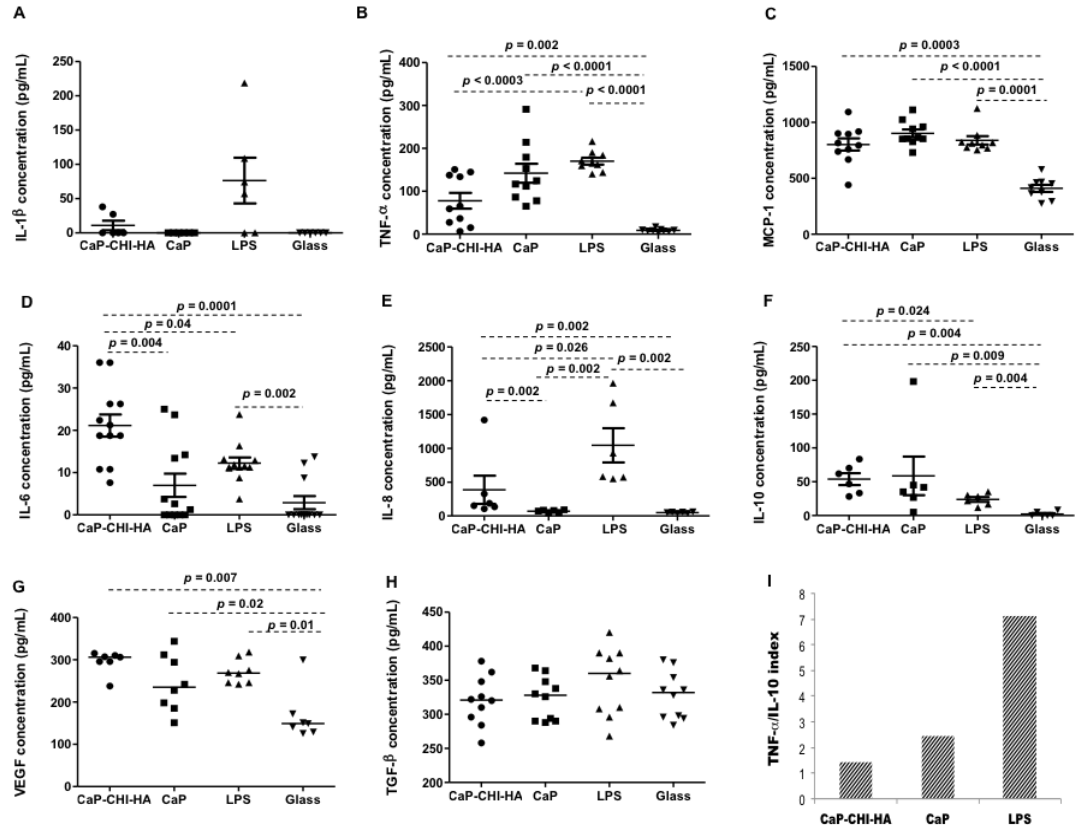
Figure 3. Cytokine, chemokine and growth factors production. Released IL-1 β ( A ), TNF- α ( B ), MCP-1 ( C ), IL-6 ( D ), IL-8 ( E ), IL-10 ( F ), VEGF ( G ), TGF- β ( H ) quantified by ELISA, indicating the secretion of pro-inflammatory cytokines/chemokines; concomitant with the secretion of IL-10 anti-inflammatory cytokine by THP-1 in contact with the build-up substrates. Mean TNF- α /mean IL-10 index ( I ), confirming a weak inflammatory profile of THP-1 in contact with the build-up substrates ( n = 10, Mann Whitney statistical test).